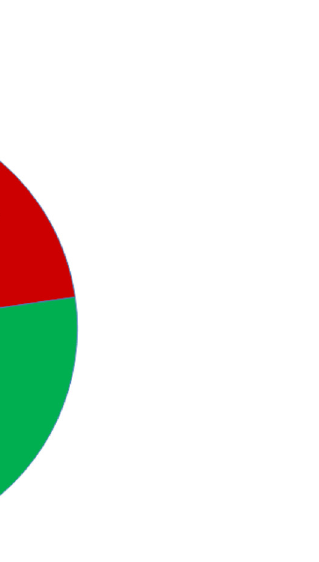
Fig 4. Serial changes of plaque phenotypes. TCFA = thin-cap fibroatheroma, ThCFA = thick-cap fibroatheroma, PIT = pathologic intima thickening.